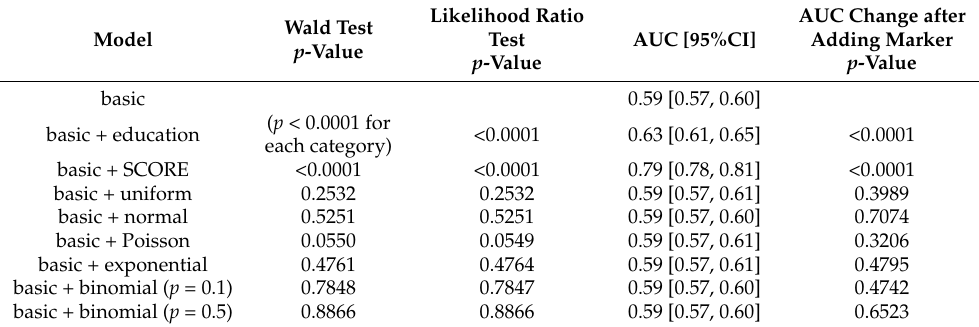
Table 5. Results of logistic regression models describing CVD risk: basic model (variables in the model: BMI, income, and daily activity) and models expanded by education, SCORE, and random variables with uniform, normal, Poisson, exponential, binomial ( p = 0.1), and binomial ( p = 0.5) distributions. Likelihood Ratio AUC Change after Wald Test Model Test AUC [95%CI] Adding Marker p -Value p -Value p